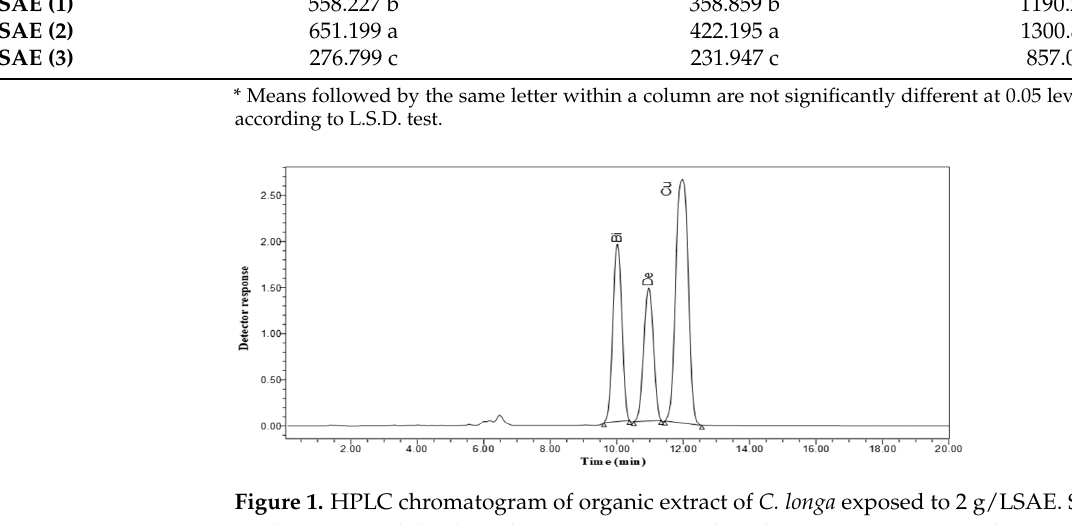
Figure 1. HPLC chromatogram of organic extract of C. longa exposed to 2 g/LSAE. Show curcumi- noids compounds bisdemethoxycurcumin (Bi), dimethoxycurcumin (De) and curcumin (Cu).